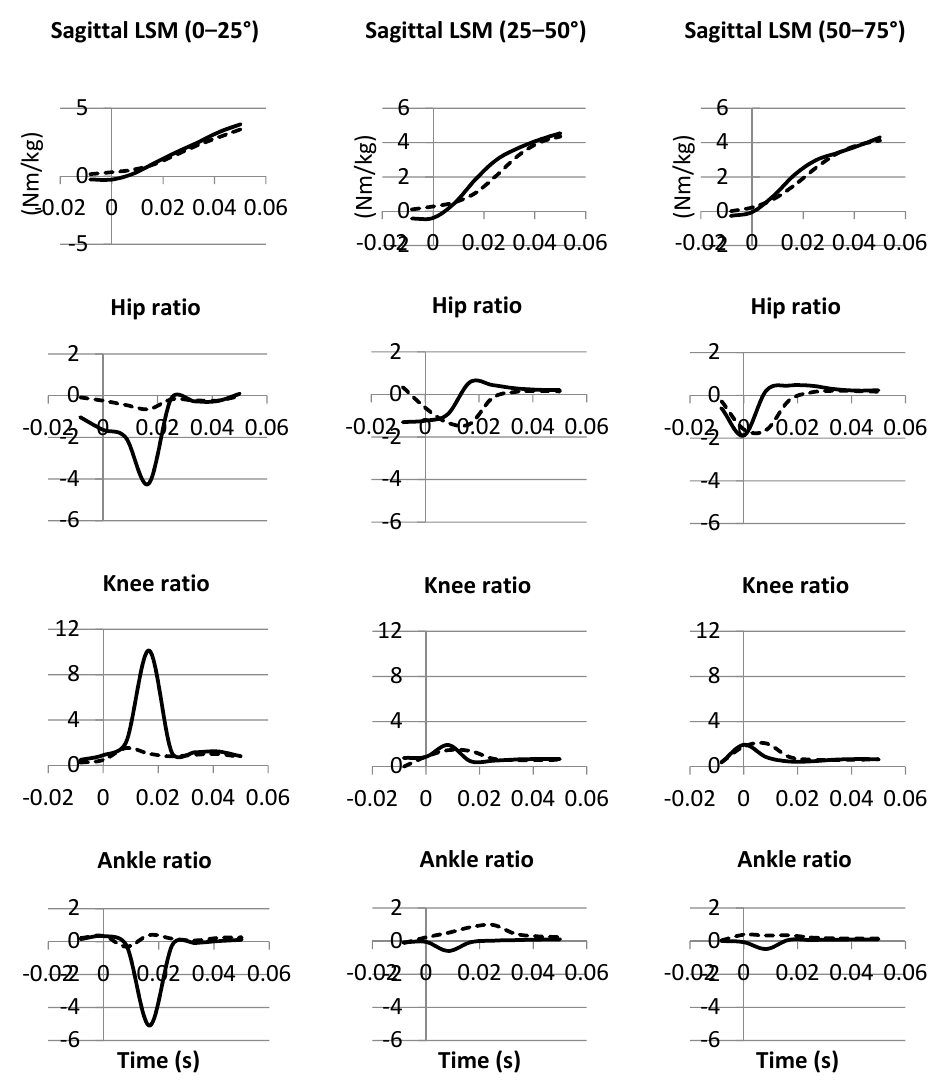
Figure 2. Sagittal plane limb support moment sex comparisons with contribution ratios for each landing condition. Male: solid line; female: dashed line. LSM at top: Sagittal LSM = MK − MH − MA. Moment ratios at each joint are expressed, relative to the LSM, as contributing (+) or not contributing ( − ) to limb support. Initial contact is 0 s.